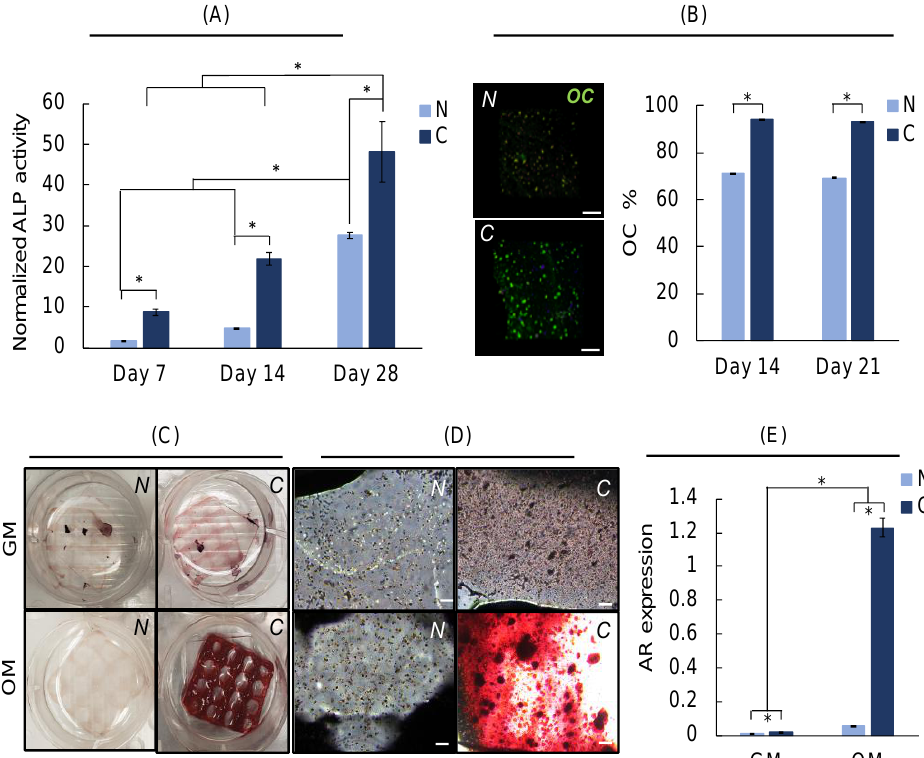
Figure 10. Differentiation results of hMSCs within bioprinted neat ( N ) or composite ( C ) hydrogels cultured up to 28 days in growth media (GM) or osteogenic differentiation media (OM). ( A ) Normalized ALP activity (with respect to day 1). ( B ) Confocal images of hMSCs showing osteocalcin (OC, green) staining at day 14 (scale bars are 200 microns) and plot showing percent OC staining for hMSCs. ( C ) Pictures of scaffolds at day 21, red color indicating alizarin red (AR) staining. ( D ) Microscope images of the scaffolds corresponding to the scaffolds in ( C ). Scale bars are 200 microns. ( E ) Plot showing AR expression at day 21. * indicates p < 0.05 for n = 3 samples per group.